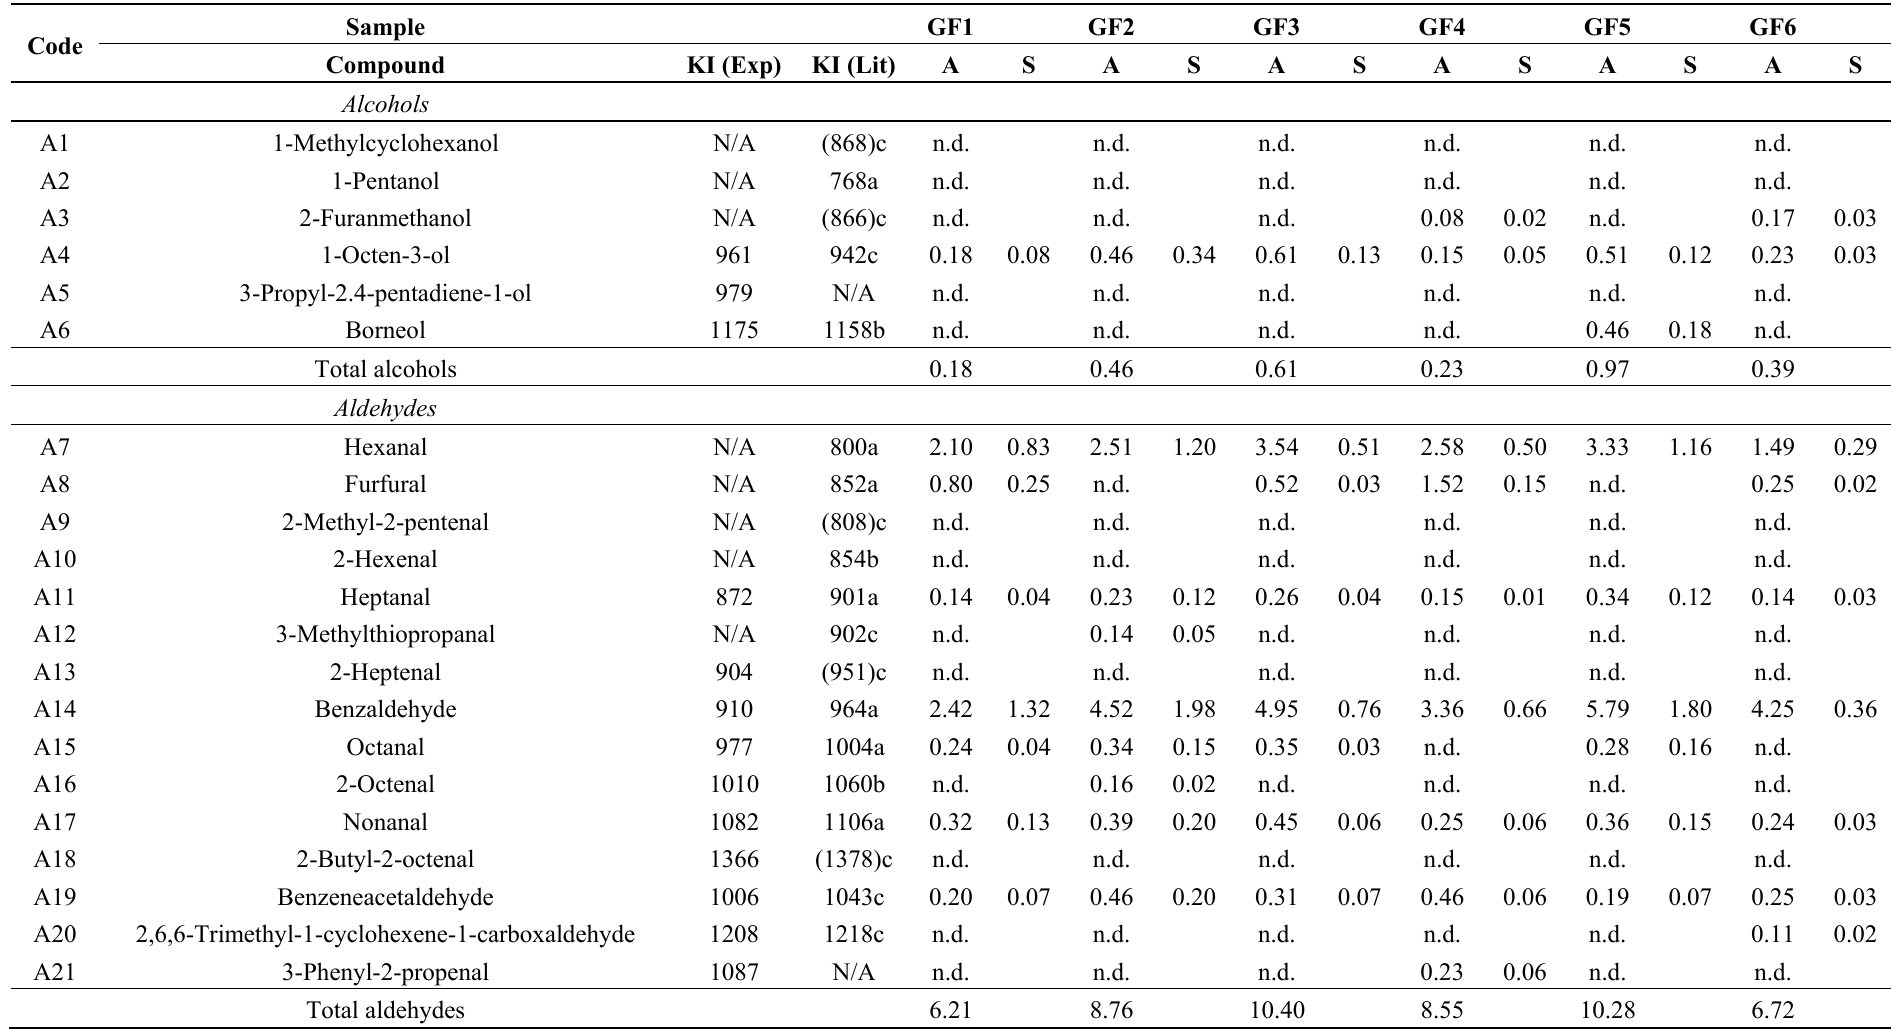
Table 1. Content (µg/kg) of aroma compounds in grain-free dog food